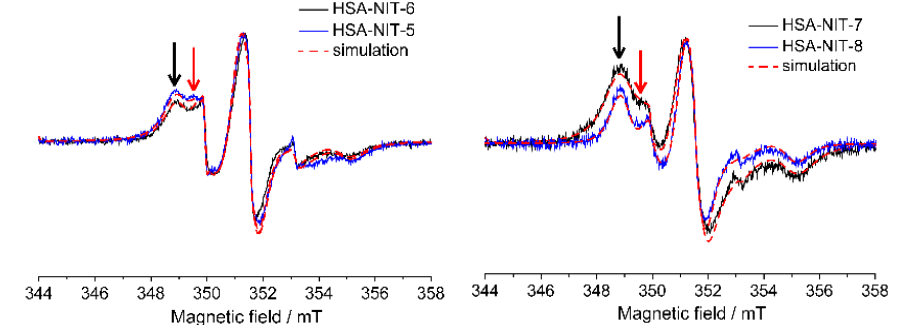
Figure 2. X-band CW EPR spectrum of spin-labelled conjugates at 300 K. Black and blue lines with noise are experimental spectra. The experimental spectra were simulated using EasySpin software [71,72]. Red lines are simulated spectra with parameters listed in Table S3. Red arrow—«fast», black—«slow» motion component.